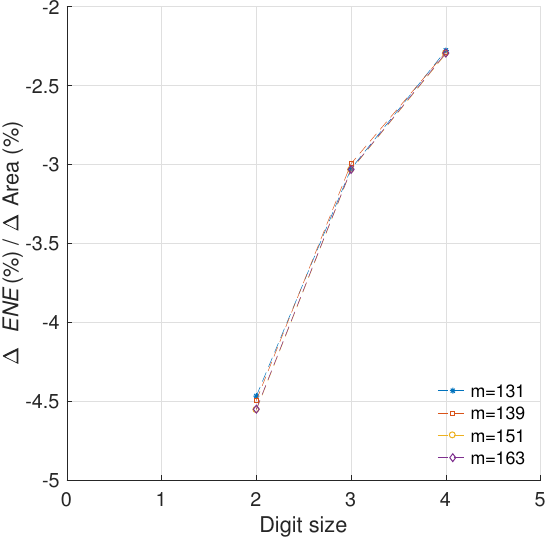
Figure 12. Evaluation of the efficiency metric for the results from